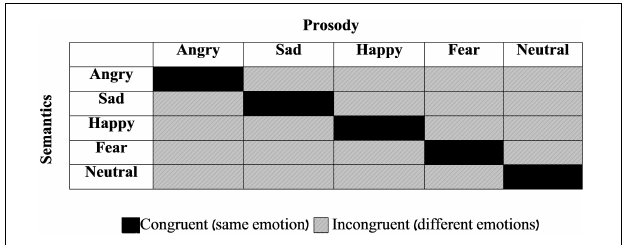
FIGURE 1 | General design of the Stimuli. All combinations of prosodic and semantic emotions are presented. Each cell represents two different sentences used in this study. Black cells: congruent sentences (same emotion in both speech channels). Gray cells: incongruent sentences (different emotions in semantics and